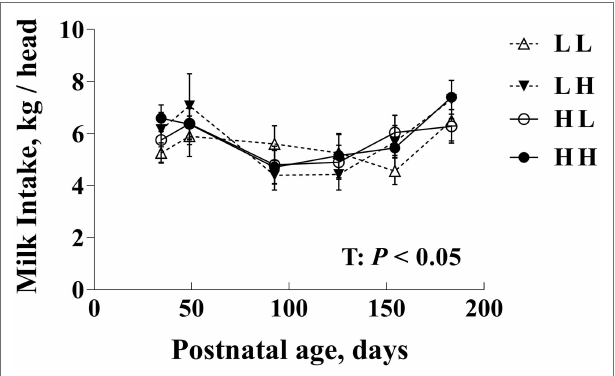
FIGURE 2 | Daily milk intake (kg/head) in bull calves prior to weaning following exposure to maternal diets low (L) and/or high (H) in protein during the peri- conception (PERI; − 60–23 dpc) and first trimester (POST; 24–98 dpc) periods of gestation 1 . T: Time effects ( p < 0.05). No significant differences between maternal diet groups overall or among groups within age ( p > 0.05). 1 LL, Low protein maternal diet during both PERI and POST diet periods. LH, Low protein maternal diet during PERI and High protein during POST diet periods. HL, High protein maternal diet during PERI and Low protein during POST diet periods. HH, High protein maternal during both PERI and POST diet